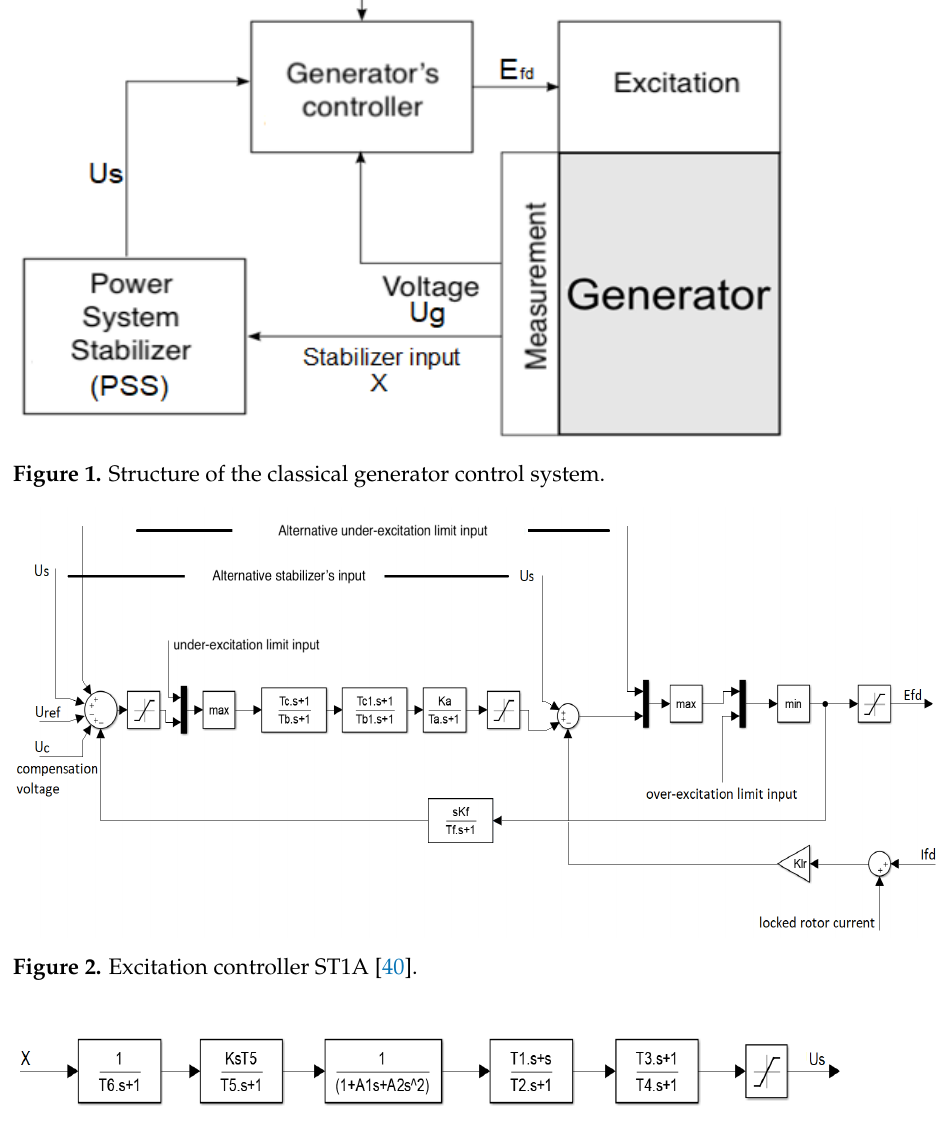
Figure 3. System stabilizer PSS1A